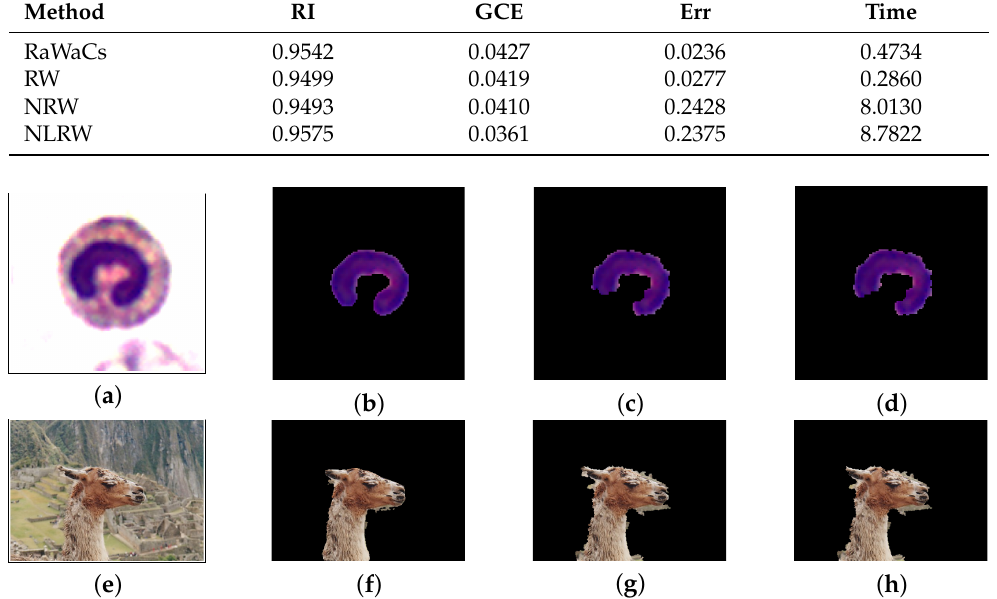
Table 2. Performance measures for the proposed procedure, the random walk, the normalised random walk and the normalised lazy random walk methods on the GrabCut dataset. σ g is set to 90 for both NRW and NLRW, while α = 0.9 for NLRW. The computational time is measured in seconds.